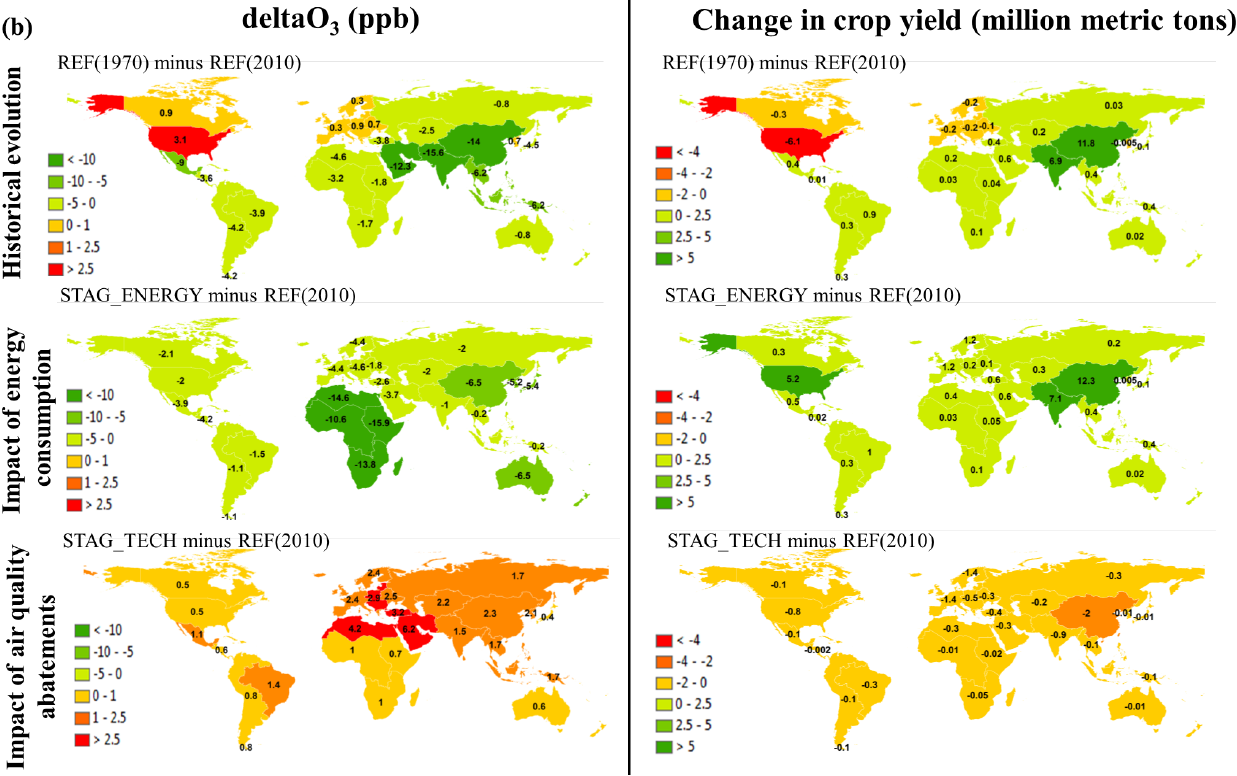
Figure 10. Relative change between the scenarios (STAG_ENERGY, STAG_TECH and REF(1970)) and the reference case (REF(2010)): regional change in (a) PM 2 . 5 (µgm − 3 ) and associated life expectancy (months) and (b) in ozone mixing ratios (ppb) and associated impacts on crops. Note that the same color scales are used for deltaPM 2 . 5 and deltaO 3 (positive delta are associated with red colors representing bad impacts, while negative delta are in green colors representing improvements). Opposite color scales are applied for change in life expectancy and crop yield compared to the delta one (positive values are reported in green and negative values in red representing good and bad impacts,